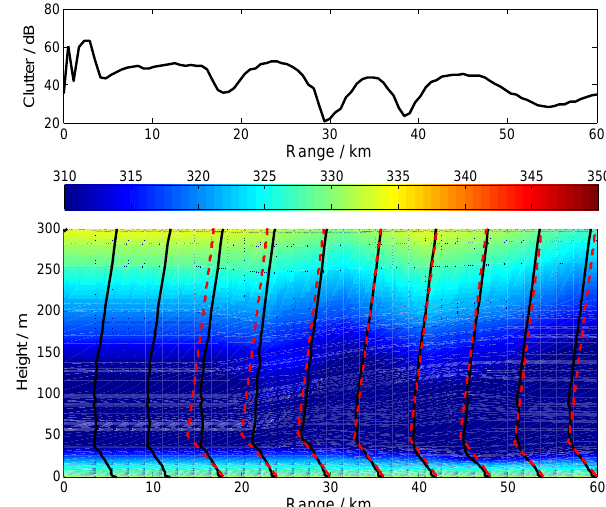
Fig. 4. The clutter return (dB) observed by the radar along azimuth 150 ◦ (top), and the contour plot of the corresponding modified re- fractivity versus range and height (bottom). The black lines indicate the measured profiles at every 6-km range bin, and the red dashed lines indicate the estimated profiles.